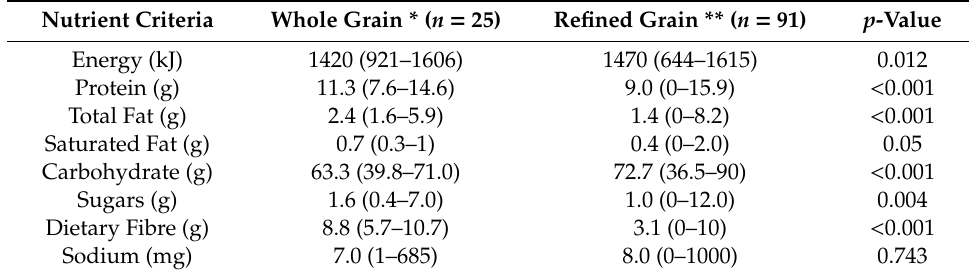
Table 3. Comparison of nutrients in whole grain and refined grain flours (per 100 g) (median and range).